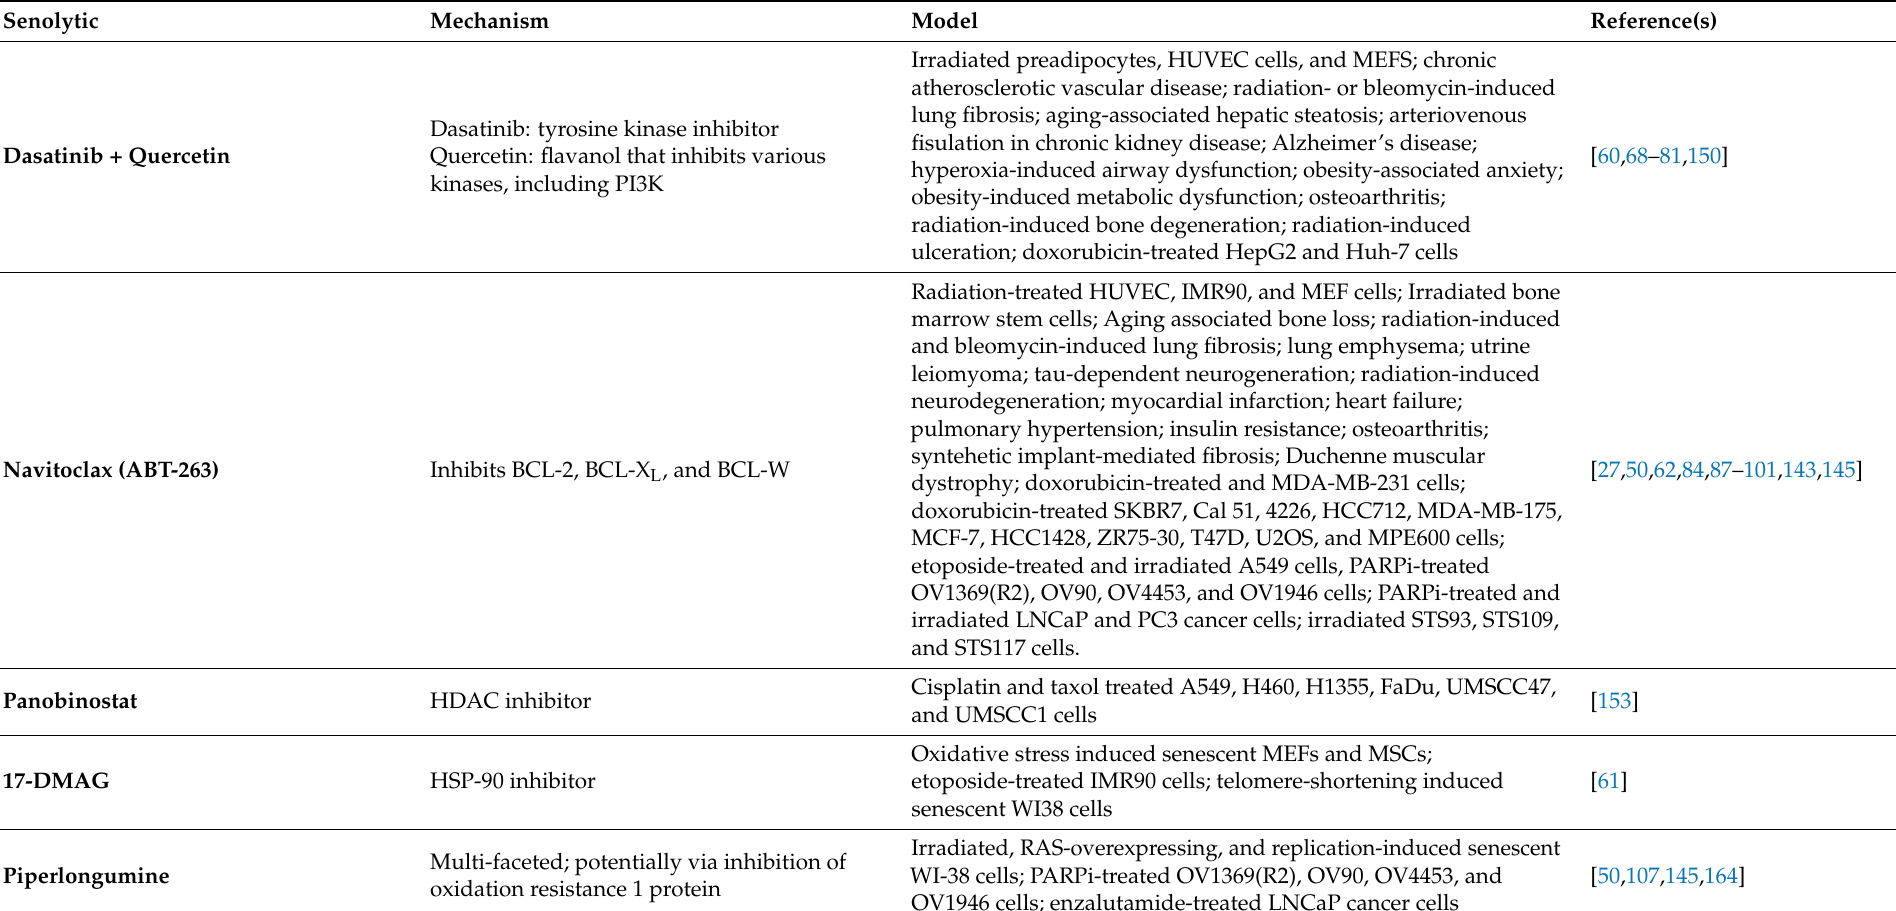
Table 1. The most commonly utilized senolytics in pre-clinical models. A multitude of compounds with differing mechanisms of action of been described as senolytics. This table, although not comprehensive of all such agents, summarizes the most commonly tested compounds, their mechanism(s) of action, and the models in which they have been tested for senolytic activity regardless of their success in exerting